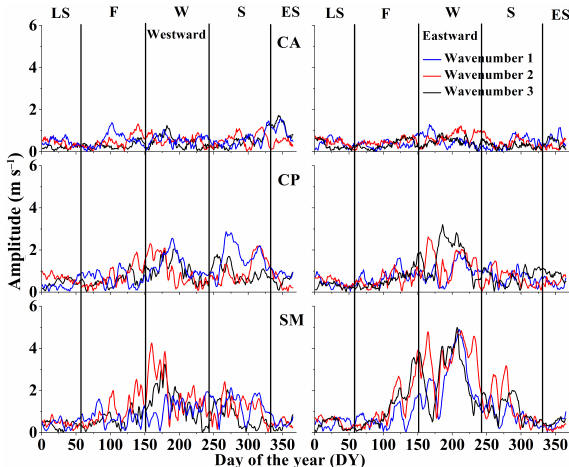
Figure 5. Longitudinal and temporal variation of the filtered ECMWF zonal and meridional winds in the period band 12–20days at 10hPa pressure level for the locations 7.5 ◦ S ( ∼ CA), 22.75 ◦ S ( ∼ CP), and 29.75 ◦ S ( ∼ SM). The arrows in the plots show the di- rection of the propagation of the waves.